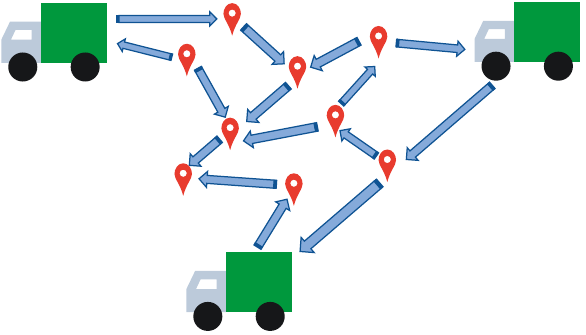
Figure 1: Vehicle path